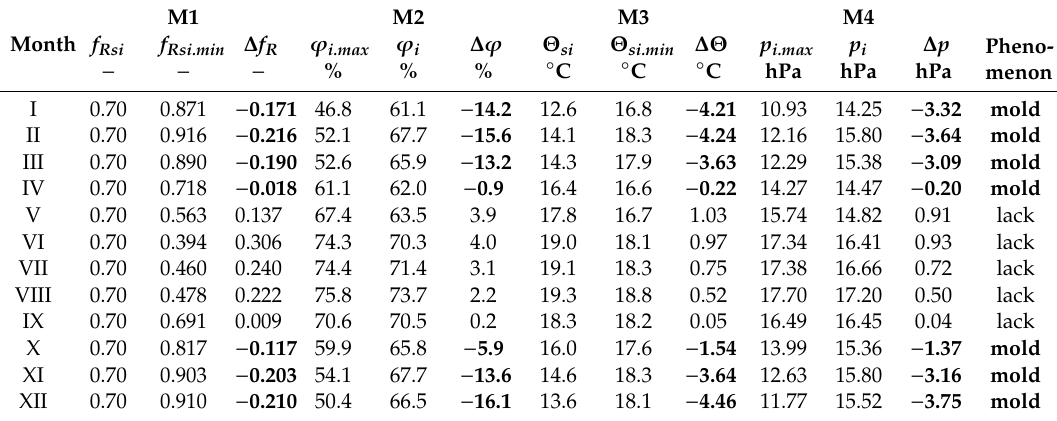
Table 9. Parameters for determining the boundary conditions for mold development and the state of the phenomenon for four methods - the bold font indicates negative values of the analyzed parameters at which the mold phenomenon occurs.